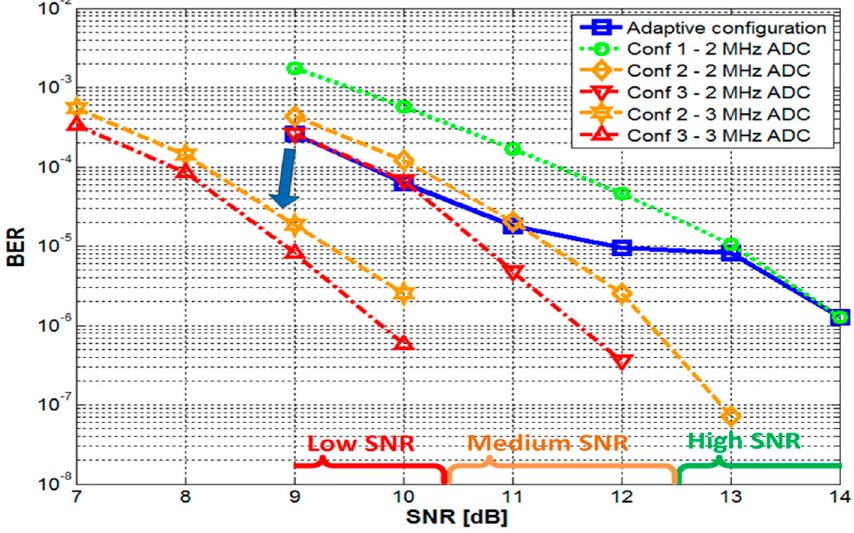
Figure 5. Bit error ratio for non-adaptive and SNR-adaptive configurations. Besides increasing the complexity of the signal processing algorithm, the bit error ratios (BER) can be further enhanced by increasing the sampling frequency.